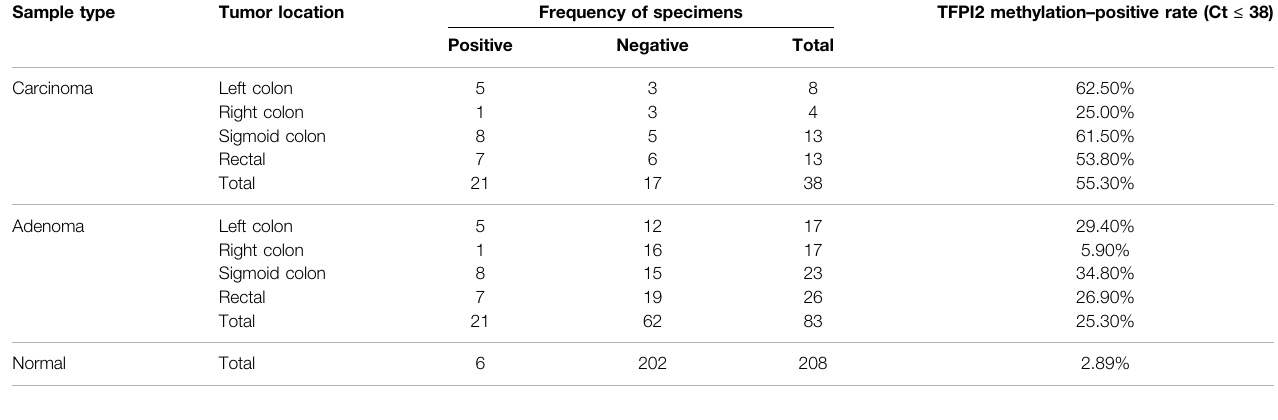
TABLE 3 | Methylation-positive rate (Ct ≤ 38) of TFPI2 within SDC2 methylation – negative (Ct ＞ 38) stool specimens. Sample type